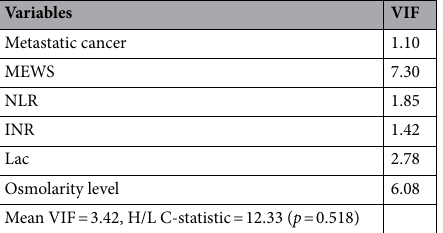
Table 9. VIF assessment of factors associated with 28-day mortality rate in validation